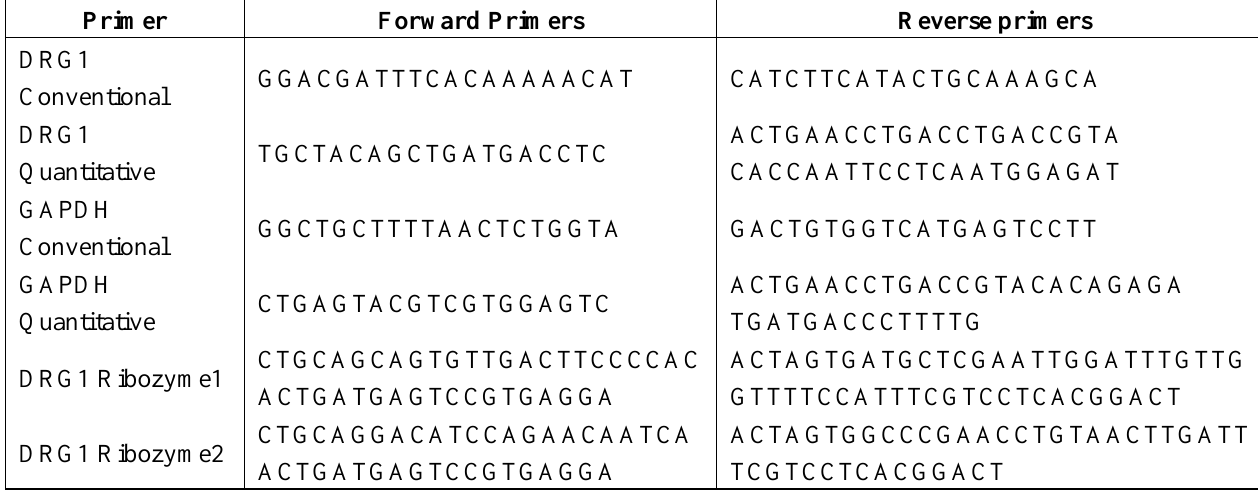
Table 2. Primer sequences used in the